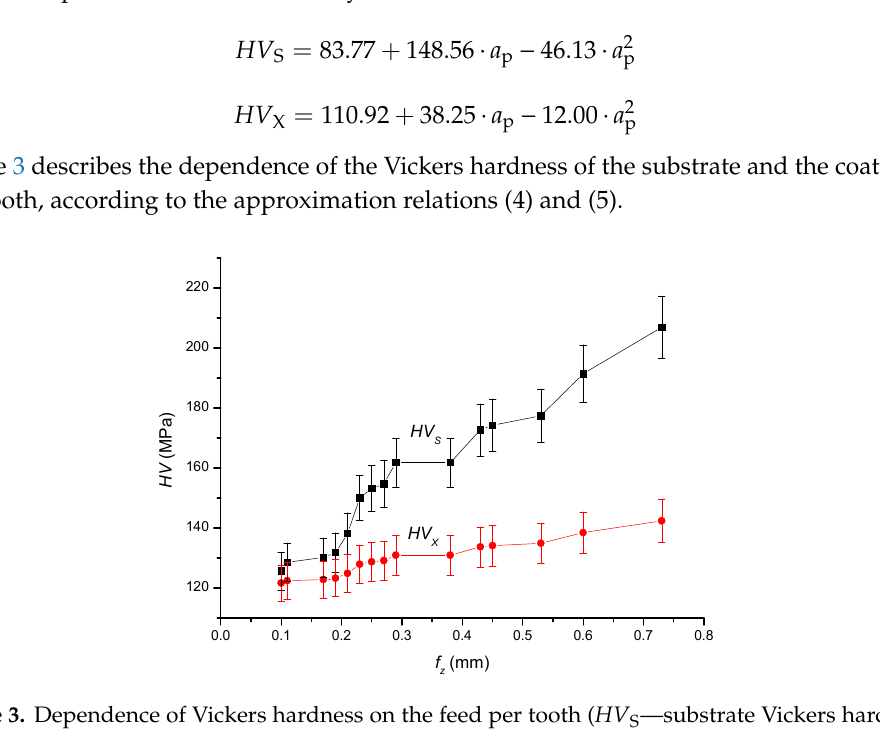
Figure 3. Dependence of Vickers hardness on the feed per tooth ( HV S —substrate Vickers hardness; HV X —spray Vickers hardness).